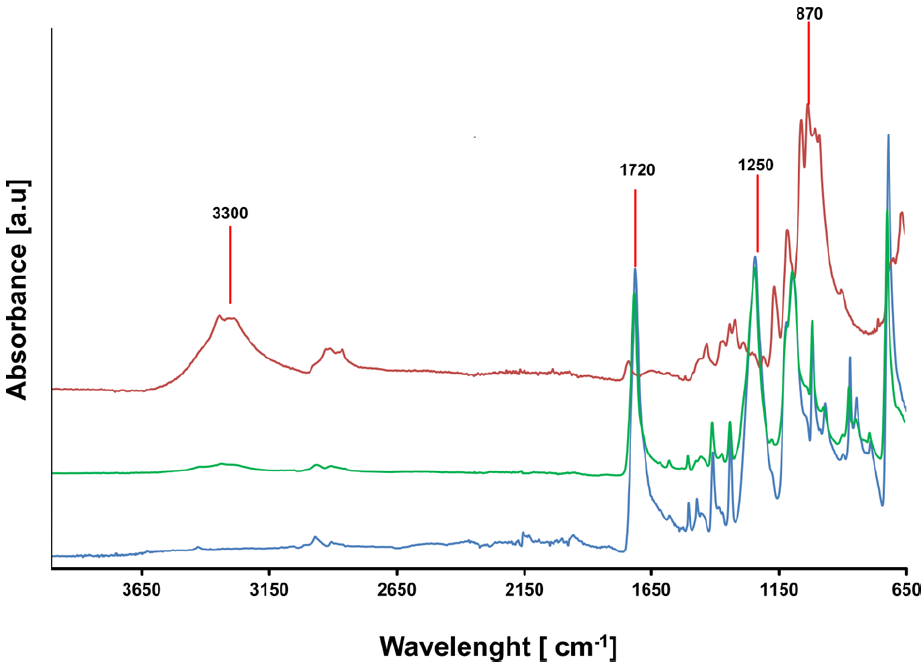
Figure 6. FT-IR real textile waste sample. Pure PET (blue line), pure cotton (red line), real textile waste sample (green line). All the spectra were normalized in the area 2500 – 2200 cm − 1 .